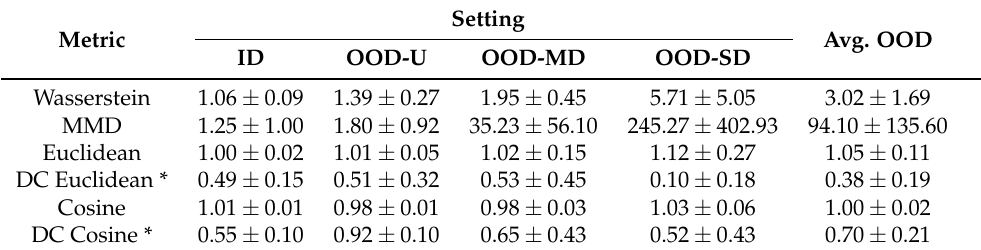
Table 4. Comparison of metrics over all four domain generalization settings based on the CNN-base representations. For each setting, values were averaged over all the datasets. All metrics are ratios except the ones with